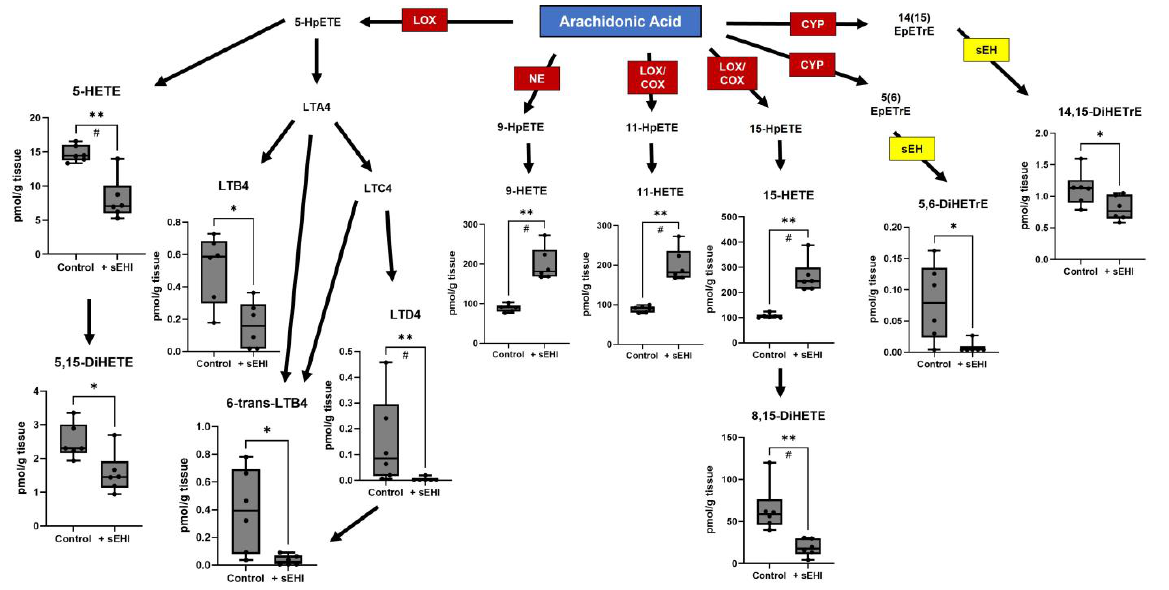
Figure 3. Oxylipins downstream of arachidonic acid altered by sEHI in males. Boxplots of oxylipins that were significantly different in the brains of male sEHI-treated and control mice are shown in a diagram demonstrating the pathways producing the oxylipins from arachidonic acid. The box extends from the 25th to the 75th percentile, with the middle line indicating the median. The whiskers extend to the minimum and maximum values, with individual values indicated by black dots. For definitions of oxylipin abbreviations see Table S1. LOX: lipoxygenase enzyme; NE: non-enzymatic; COX: cyclooxygenase enzyme; CYP: cytochrome p450 enzyme; sEH: soluble epoxide hydrolase; * p < 0.05; ** p < 0.01; # FDR adjusted p < 0.05.